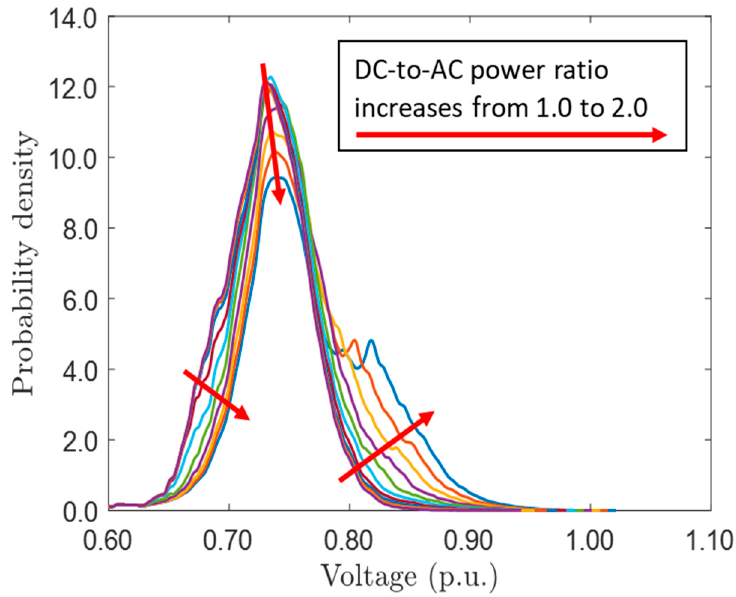
Figure 12. The probability density distributions of the operating voltage for DC-to-AC power ratios between 1.0 and 2.0 with a step of 0.1 during the observation period.